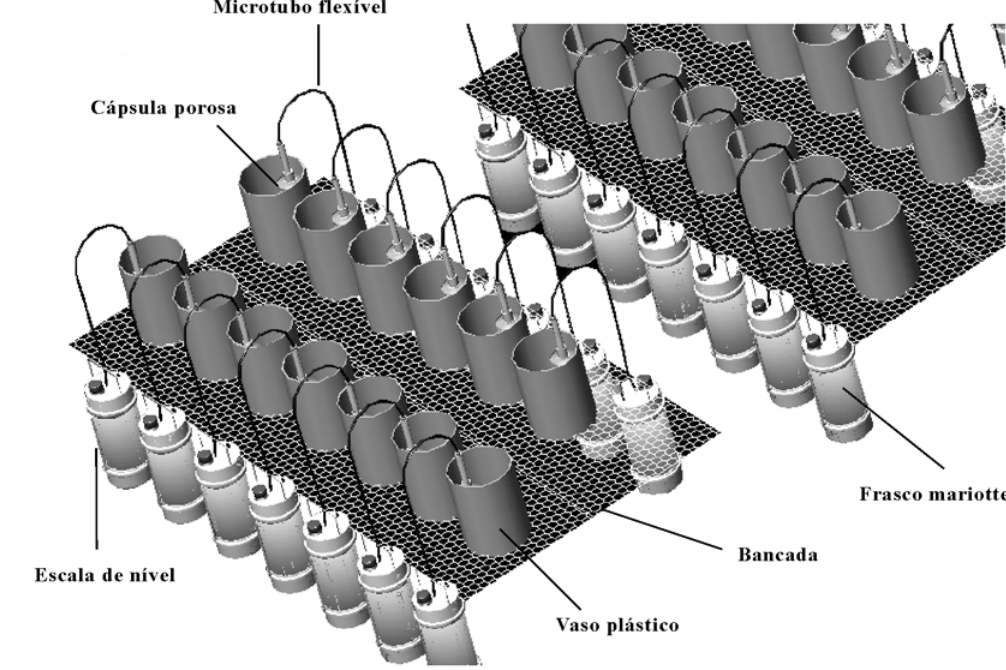
Figura 1. Representação do sistema de irrigação subsuperficial por tensão controlada com cápsula de porcelana